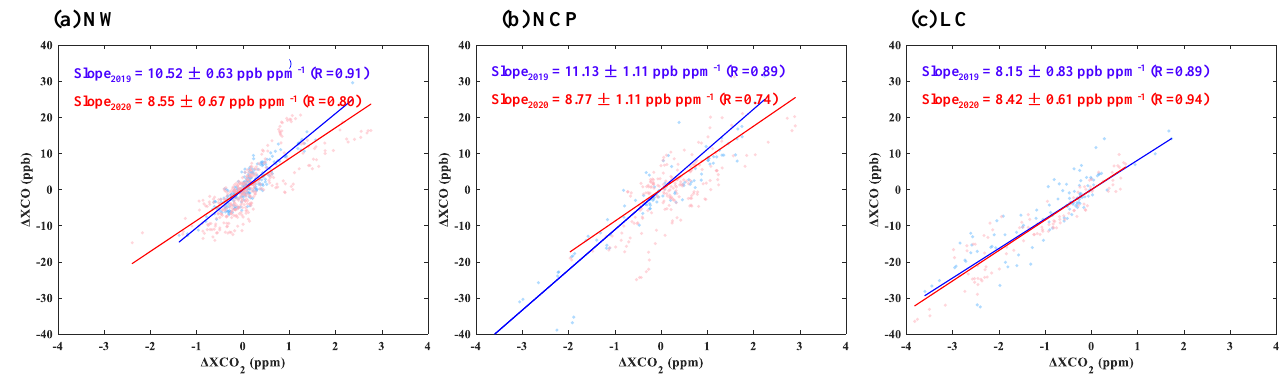
Figure 7. Correlations of ΔXCO and ΔXCO 2 in 2019 originating from ( a ) NW, ( b ) NCP, and ( c ) LC.